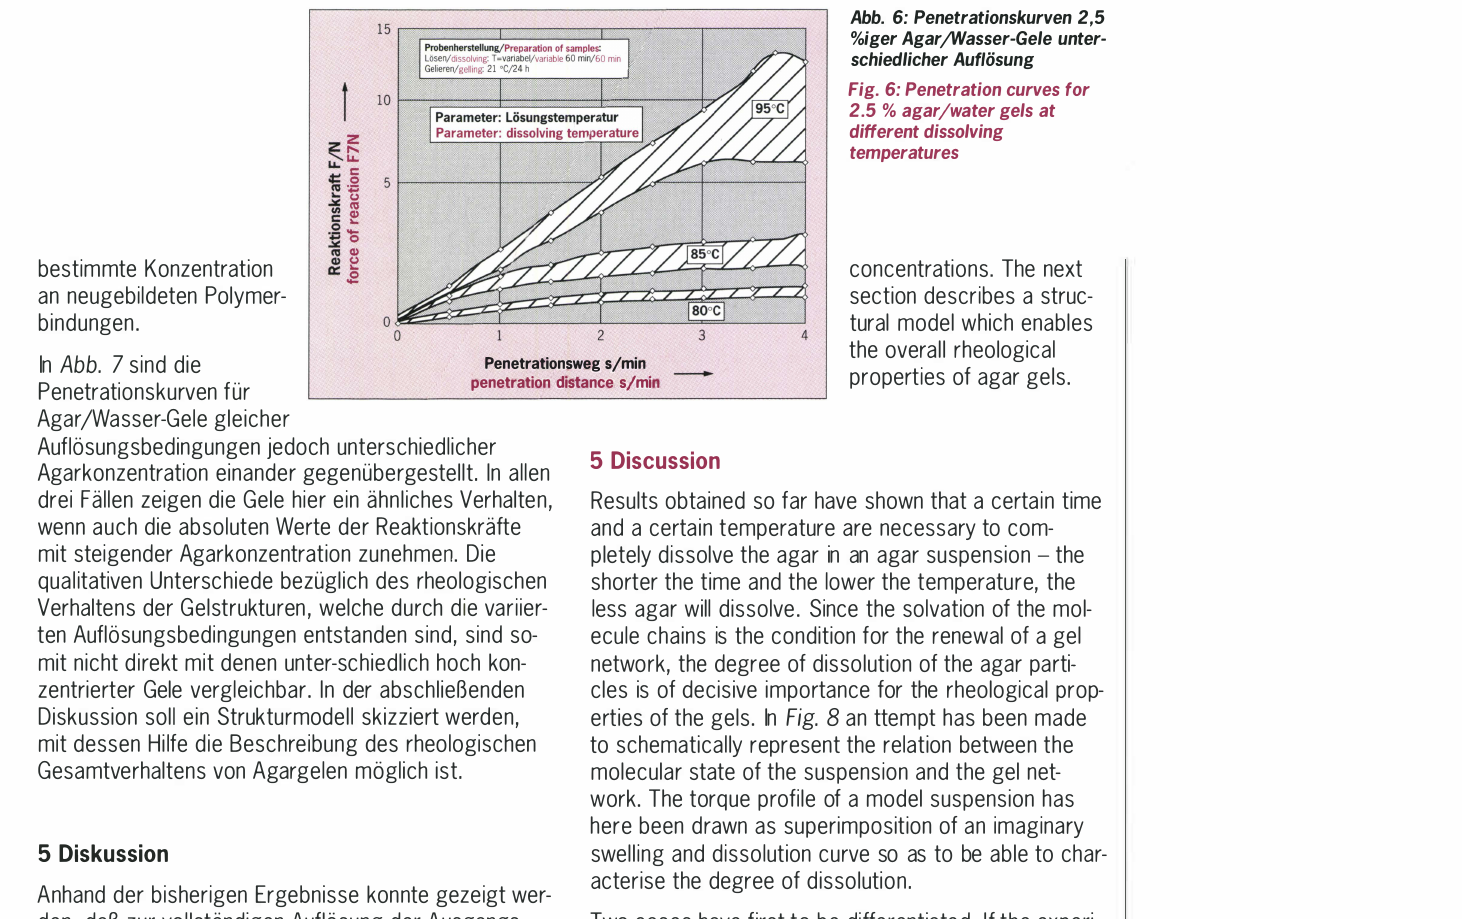
Fig. 6: Penetration curves for 2.5% agar/water gels at different dissolving temperatures